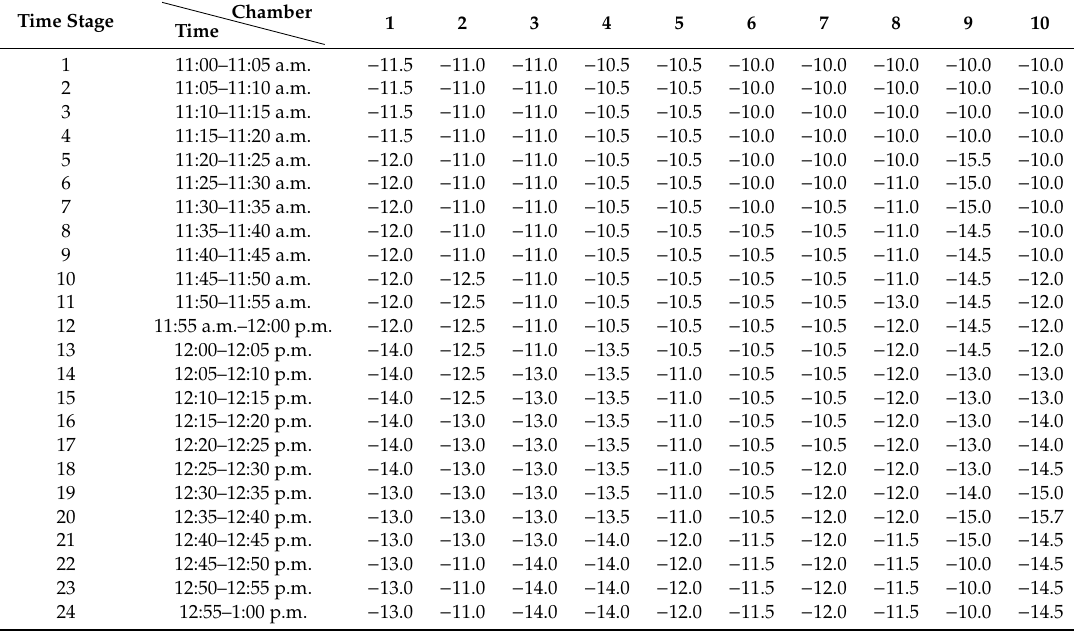
Table 5. Temperature changes of refrigerating chamber load in various time stages ( ◦ C).